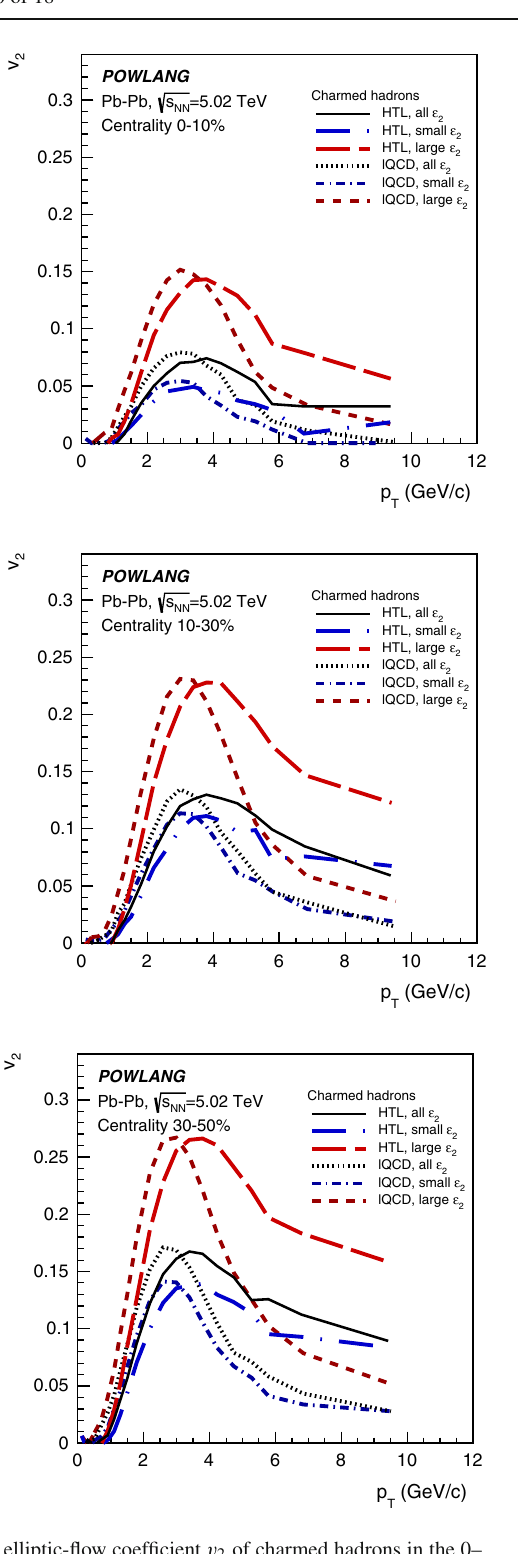
case and displayed together with ALICE data [30]. For both choices of transport coefficients the results display a strong and similar sensitivity to the initial